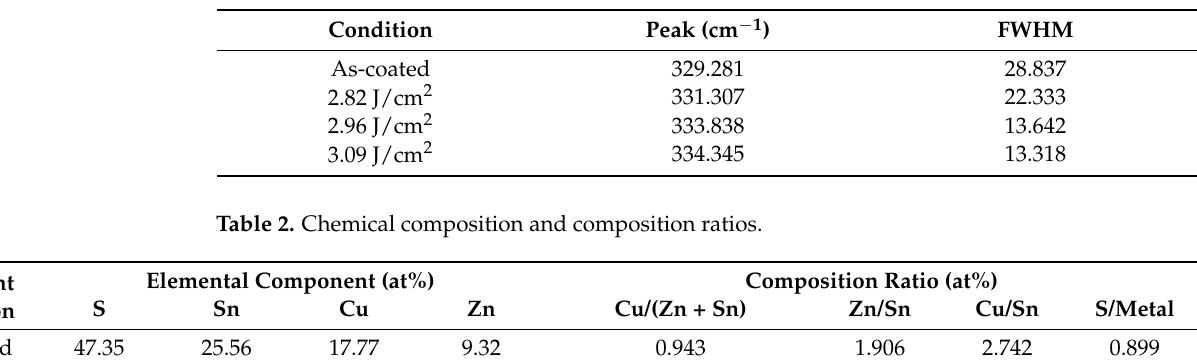
Table 1. Raman analysis of photo-sintered CZTS thin films at the highest peak positions.